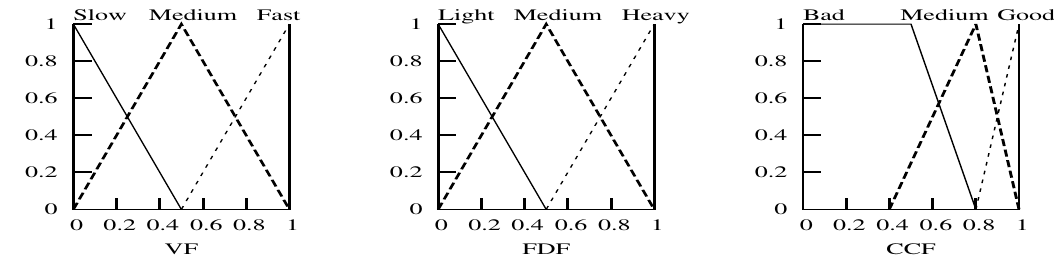
Figure 2. Fuzzy membership functions (( left ): VF , ( middle ): FDF , ( right ): CCF ).